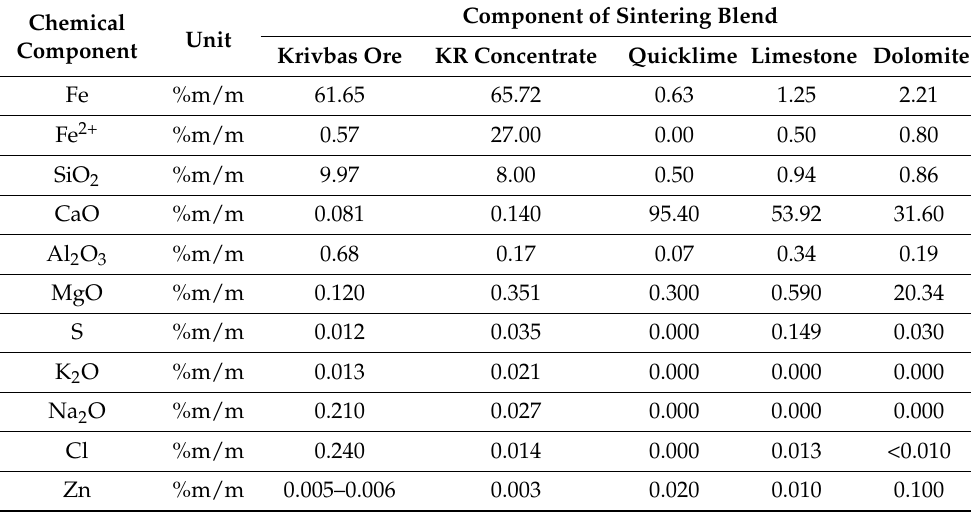
Table 3. Chemical composition of noncombustible components of the sintering